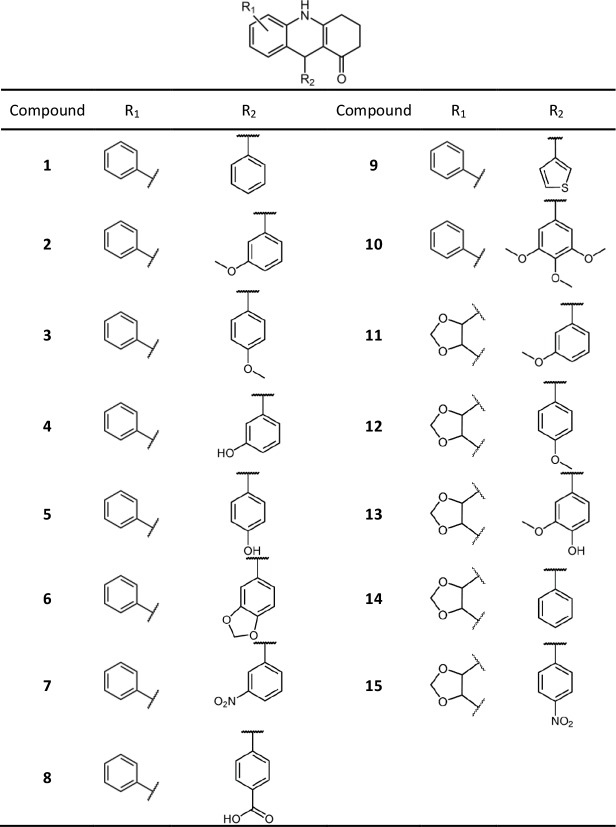
Structures of the synthetic acridinones.